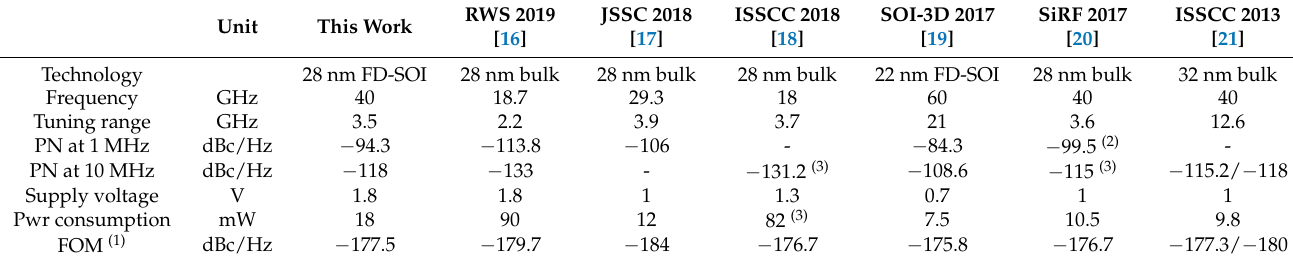
Table 1. VCO performance summary and state ‐ of ‐ the art comparison.